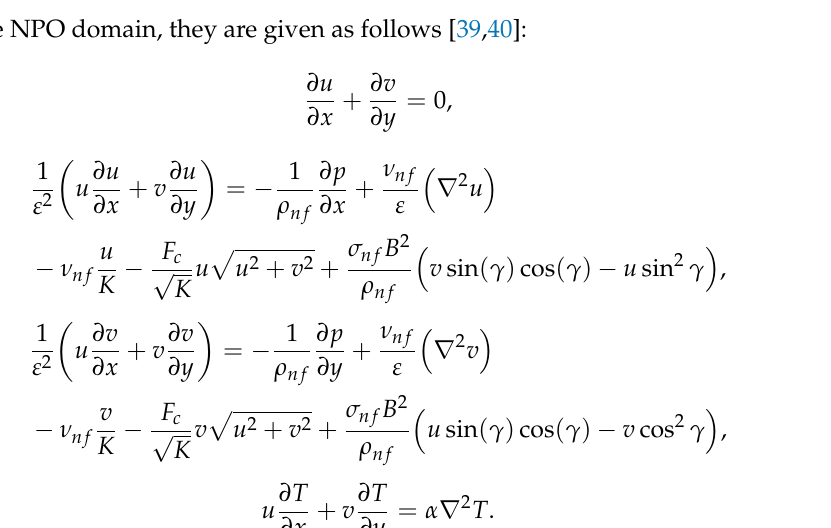
Figure 1. Model description with boundary